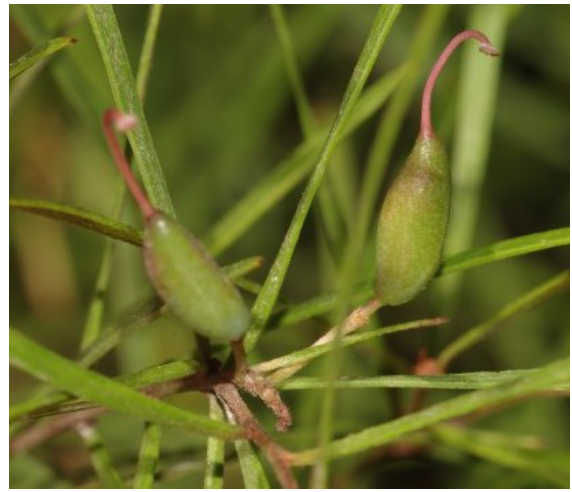
F IGURE 3: Seedpod of Grevillea parviflora subsp. parviflora at the Becks Rd site